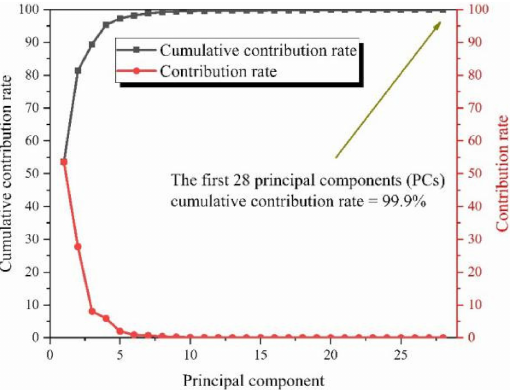
Figure 7. Contribution proportion of each principal component and their cumulative